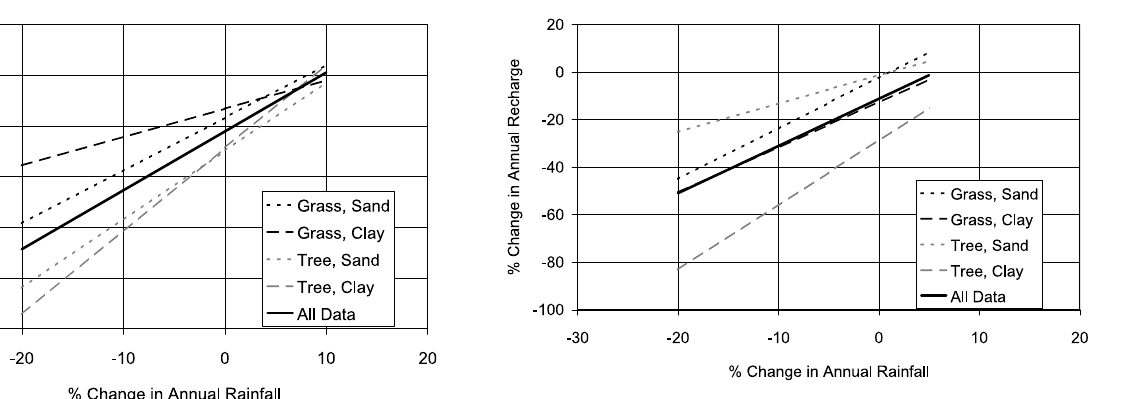
Fig. 5. Percentage change in rainfall versus percentage change in recharge to water table in SWAMS